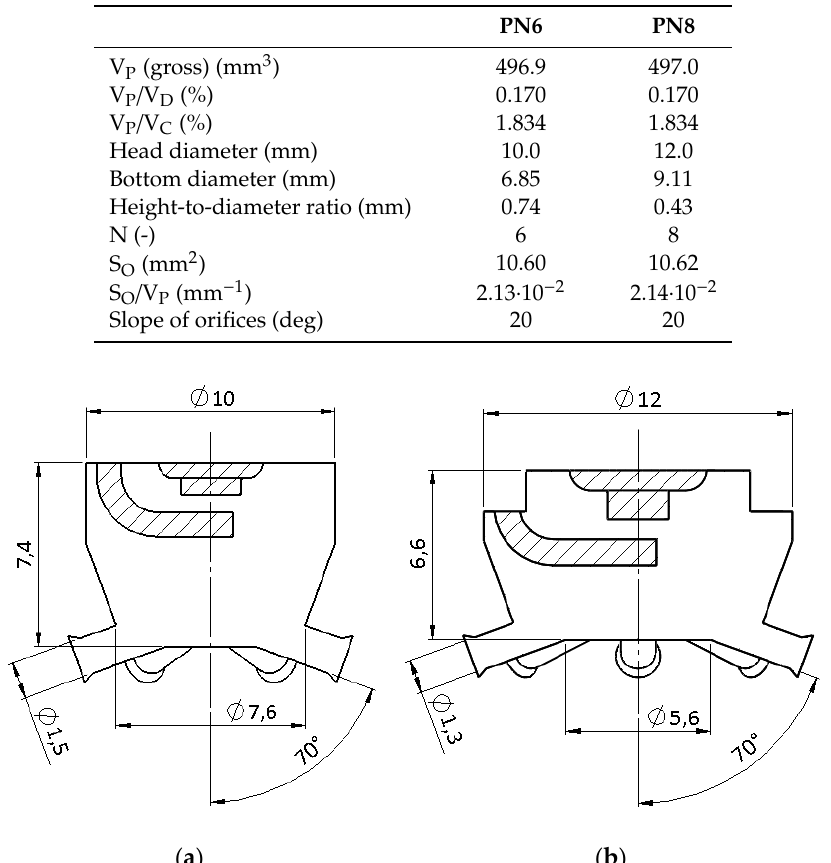
Figure 3. ( a ) Drafting of the PN6 prechamber; ( b ) drafting of the PN8 prechamber.